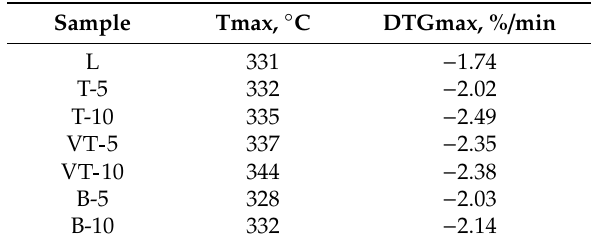
Table 3. Parameters of the thermodestruction rate of cellulose and composite fibers: the temperatures of minimums and the DTG values.